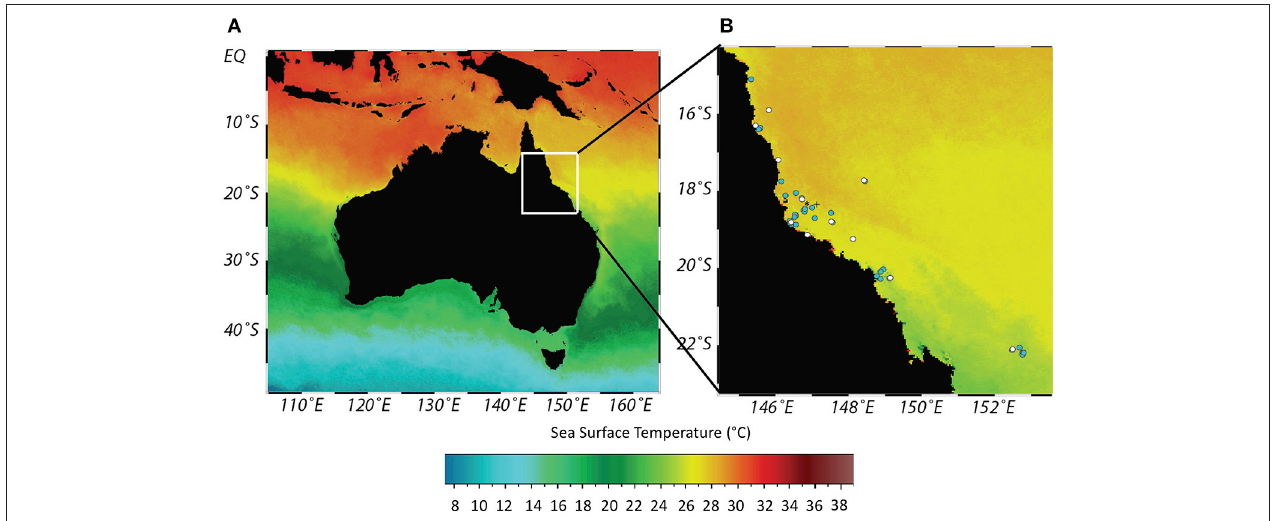
FIGURE 1 | Sea surface temperature (SST) chart of Australia (A) and location of coral cores from Great Barrier Reef (GBR) (B) . Dot shading indicates locations where coral cores bleached (white dot)/did not bleach (blue dot) in synchrony with either ENSO, PDO or SOI extremes over a 503 (ENSO, PDO) or 138 (SOI) year period depending on core length. Rib and Kelso reefs denoted by * and + respectively. Constructed using Ocean Data View. Core locations detailed in Table SM1 . Overlaid Sea Surface Temperature (Celsius) at 4km resolution from Aqua MODIS 11 µ Daytime 2016 annual composite ( NASA Goddard Space Flight Center Ocean Biology Processing Group, 2017). Overlaid annual composite is indicative to show the presence of a thermal gradient across the